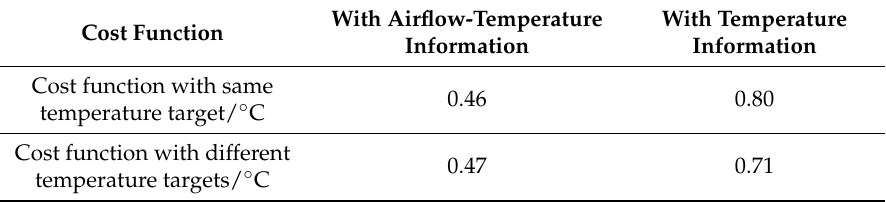
Table 2. Comparison of cost function value with different sensing information. Cost